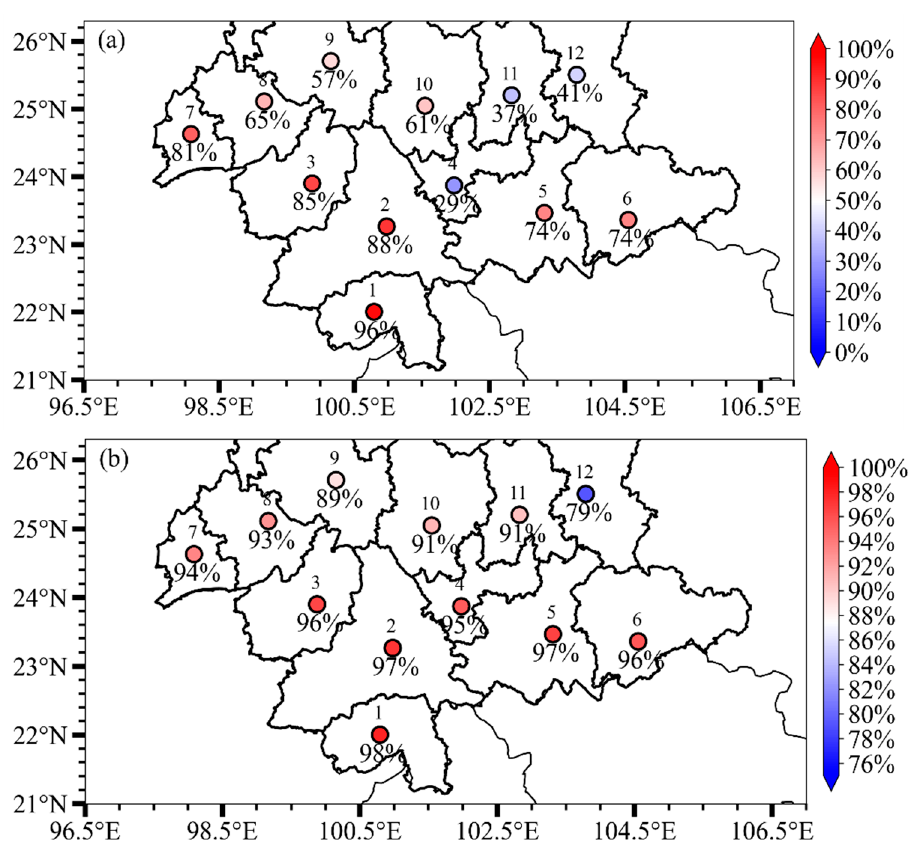
Figure 9. Spatial distribution of the contribution rates of BB emissions to PM 2.5 concentrations at 12 sites (the numbers 1–12) over YP: ( a ) at the surface and ( b ) at 700 hPa. Table 5. Regional average contribution rates of BB emissions over the Southeast Asian region to PM 2.5 concentrations at the surface and 700 hPa over SR and RR, and the regional average increments from the surface to 700 hPa in the two regions.